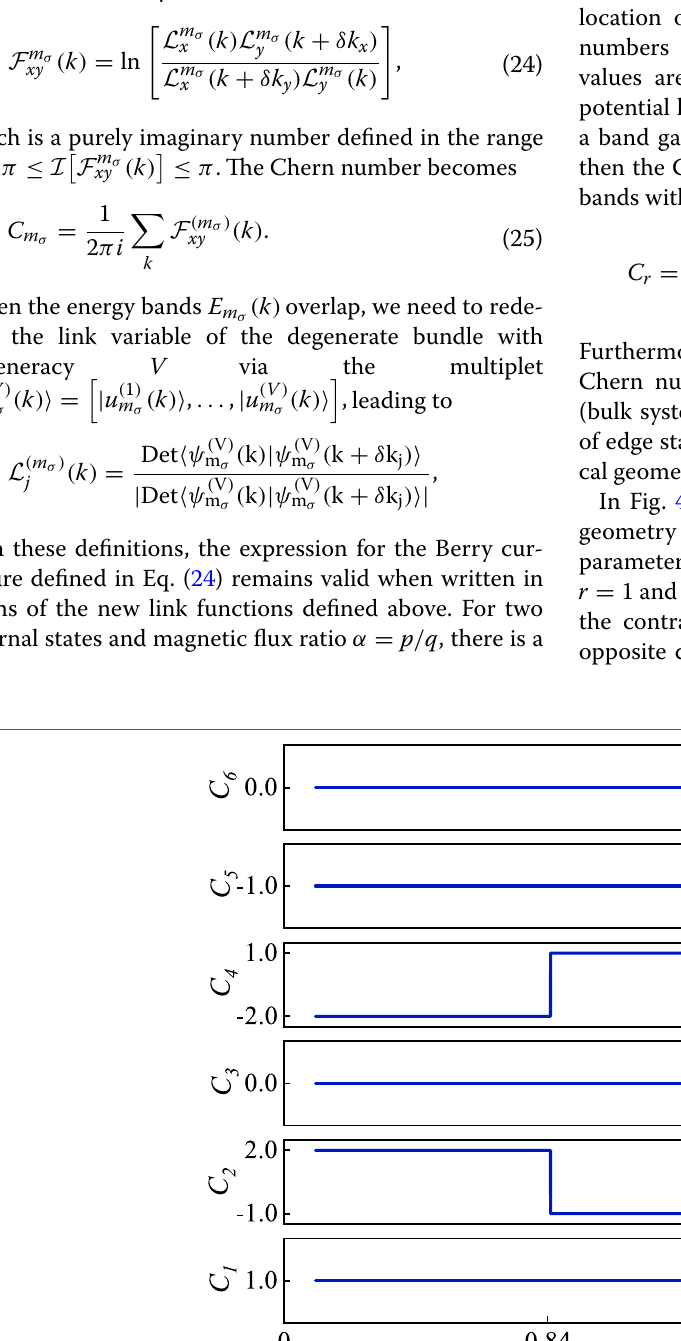
Fig. 4 Chern numbers C r calculated from the torus geometry are shown for different filling factors ν = r / 2 q ( r example, it can be seen that a step change occurs at the critical point k T ∼ 0.84 . The other parameters chosen are α = 1 / 3 , β = 0.2 π , a = 1 , g = 0.5 , and W =